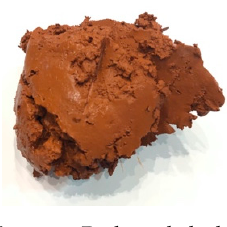
Figure 1. Red mud sludge. Table 1. Physical properties and chemical composition of red mud sludge.